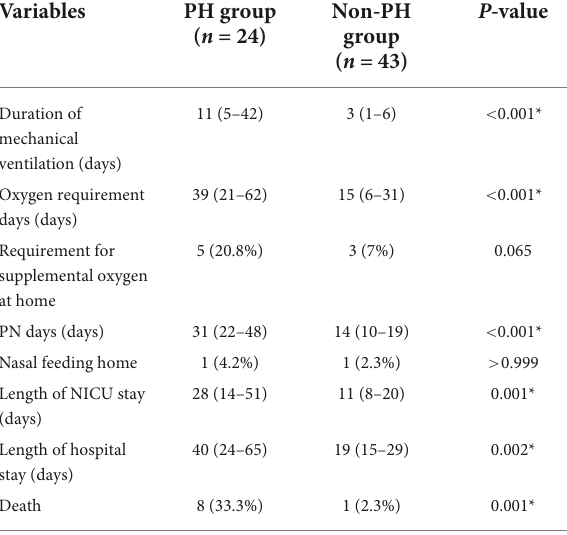
TABLE 4 Clinical characteristics of death and survival groups in infants with